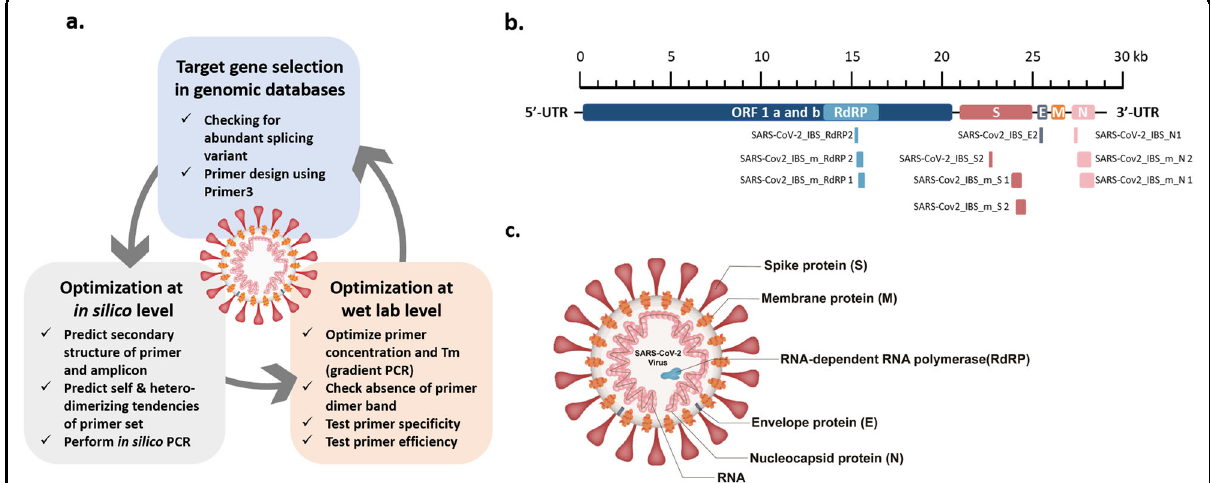
Fig. 1 PCR primer design and optimization guidelines, SARS-CoV-2 genome map, and targets of primer sets. a Three-step guidelines for PCR primer design and optimization. Step 1: target genes were selected from genomic databases, and primers were designed using Primer3. Step 2: the primer sets were optimized in silico to avoid secondary structure in the primers or untargeted ampli fi cation. Step 3: the designed primers were optimized at the wet-lab level to achieve a high speci fi city and ef fi ciency for detecting the targets. b Location of target genes and the selected primer sets in the SARS-CoV-2 genome. c The structure of SARS-CoV-2, showing each protein and its